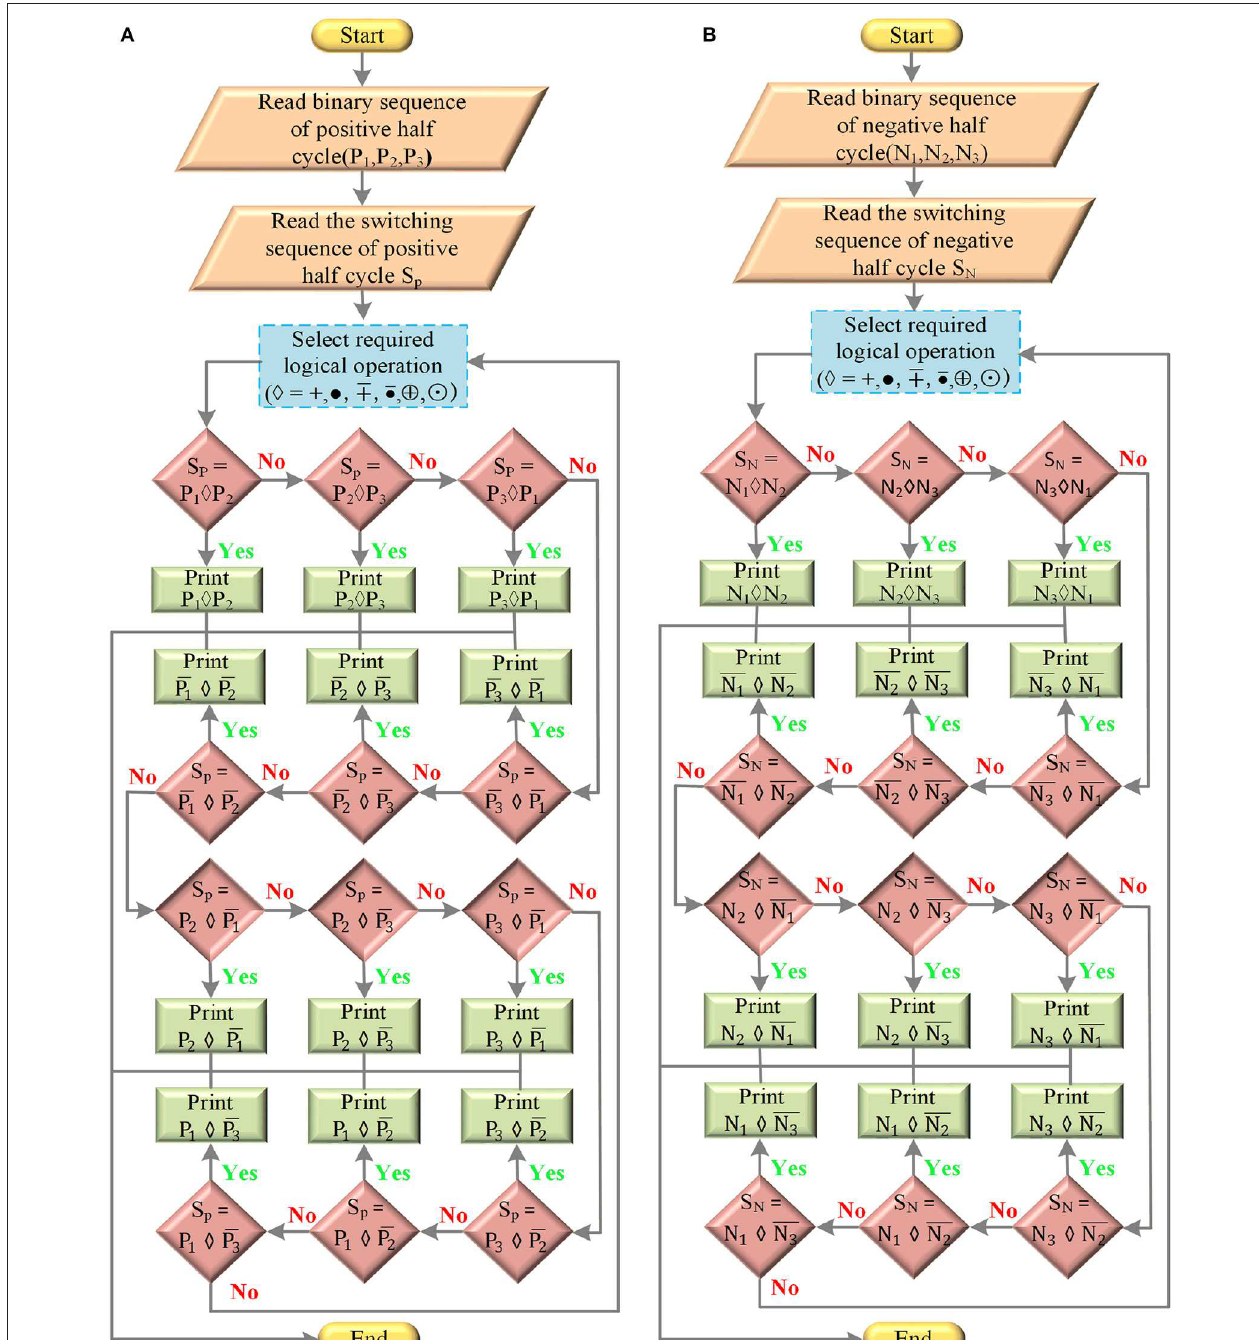
FIGURE 5 | Flowchart for selecting the two-variable pulse sequence. (A) Positive switching sequence. (B) Negative switching sequence.